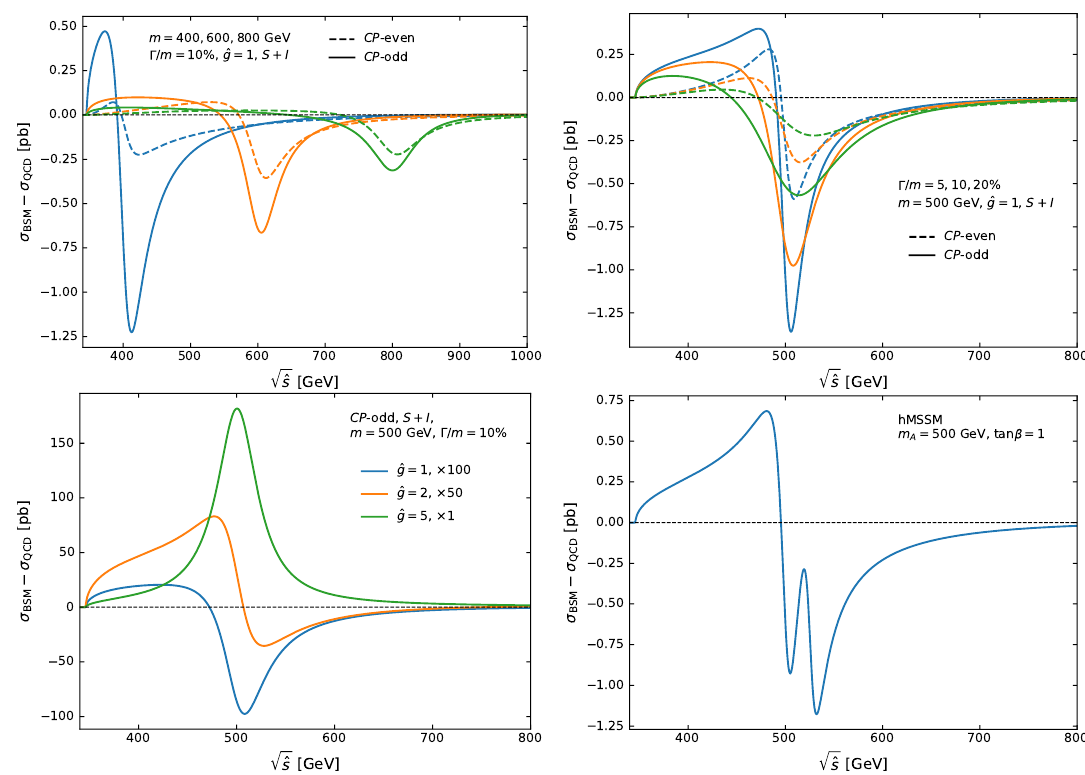
Figure 3 . Examples of parton-level cross sections for the sum of the signal process and the interference. The top row shows cross sections for di(cid:11)erent masses (left) and total widths (right). The lower left plot shows the dependence on the value of the ^ g scaled by additional factors speci(cid:12)ed in the legend. The lower right plot shows the cross section for a sample point in the